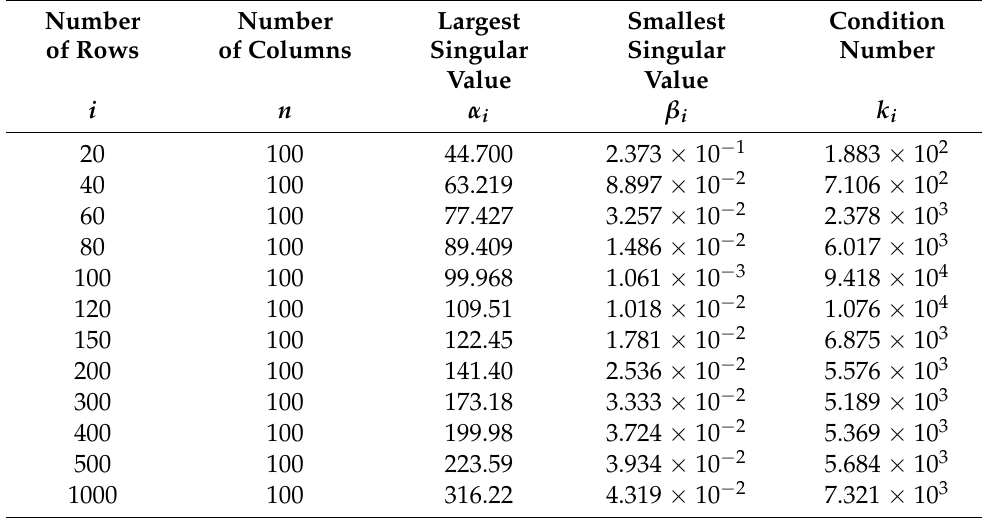
Table 10. Failure of anomaly in matrix with “converging rows”.